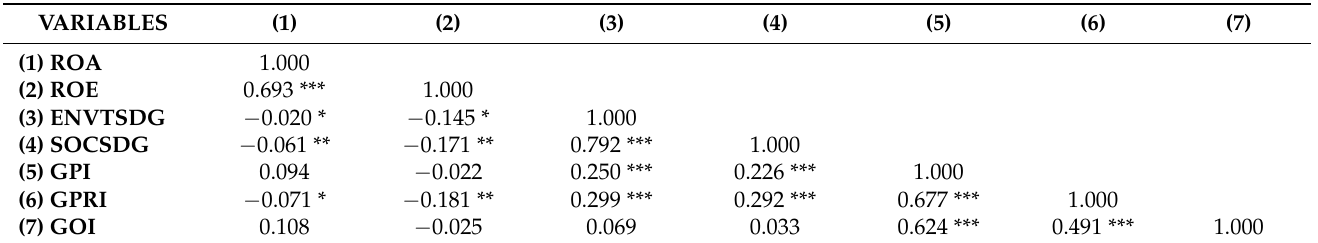
Table 5. Pearson correlation